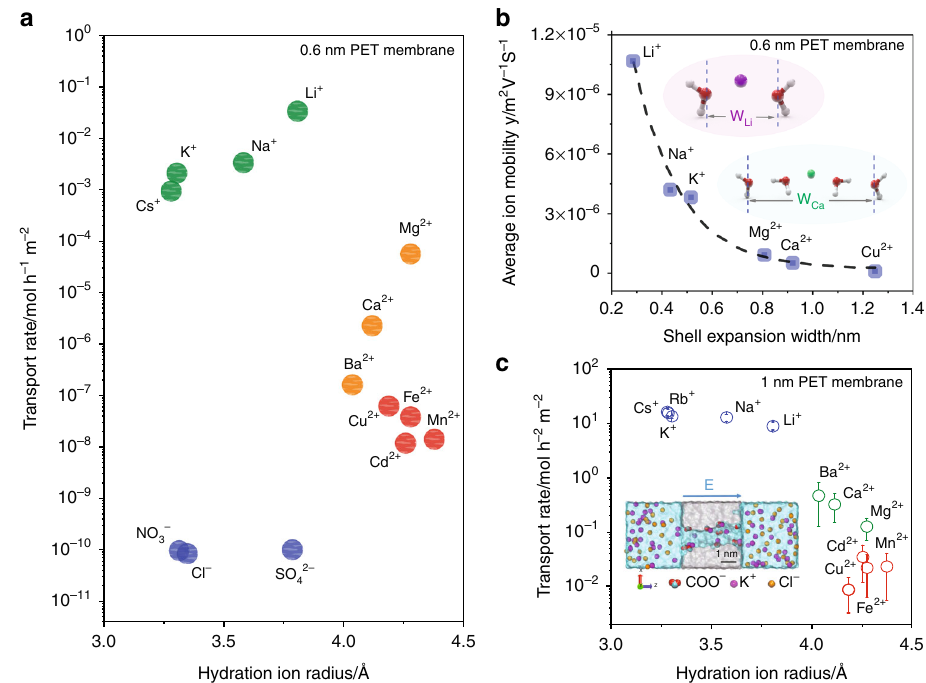
Fig. 1 Effect of nanochannel size on Li-ion selectivity and performance. a Transport rate vs. hydration ion radius and b ion mobility vs. hydration shell width w of ions inside 0.6nm diameter PET membrane. The dashed line in b is a guide to the eye. Insets represent partially dehydrated Li + ions having more compact structures, with smaller size of the hydration shell, than Ca + and thus exhibit higher ion mobility and conductivity through the nanochannels. Reprinted with permission from ref. 42 Copyright 2019 John Wiley and Sons. c Ionic transport rates of cations as a function of hydration radius in 1nm diameter PET membrane. The inset represents the model structure of the PET nanochannel. Filled circles; brown = CL − , purple = K + , green and red = COO − . Error bars represent the range of measurements of transport rate over the many events ( c ), reprinted from ref. 43